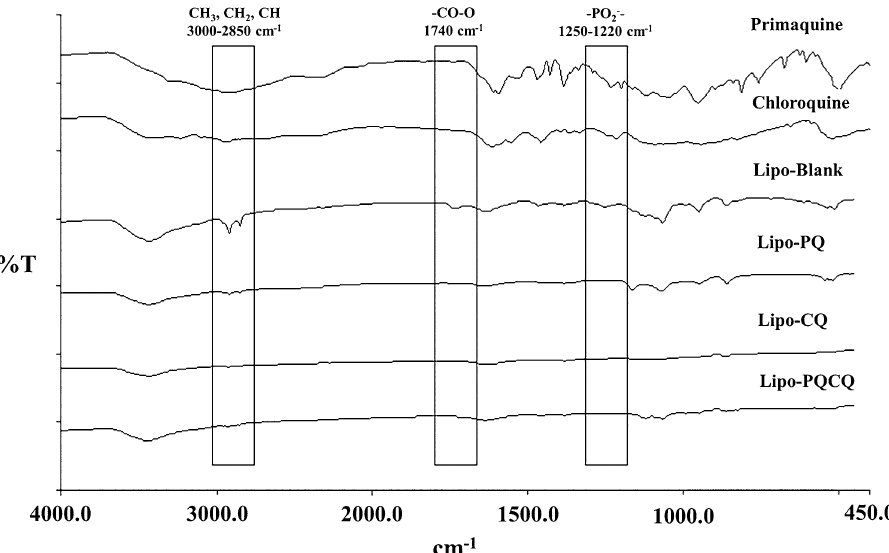
Figure 1. Fourier-transform infrared spectra of primaquine, chloroquine, blank liposomes (Lipo-Blank), primaquine-loaded liposomes (Lipo-PQ), chloroquine-loaded liposomes (Lipo-CQ), and liposomes loaded with both primaquine and chloroquine (Lipo-PQCQ) analyzed using the KBr pellet